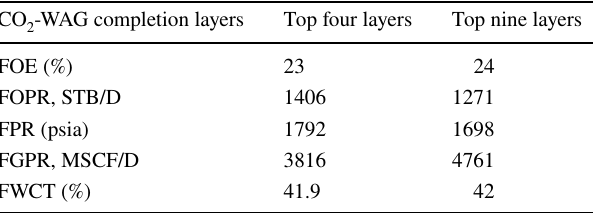
Table 12 CO 2 -WAG performance in case of different completion schemes of the injector well CO 2 -WAG completion layers